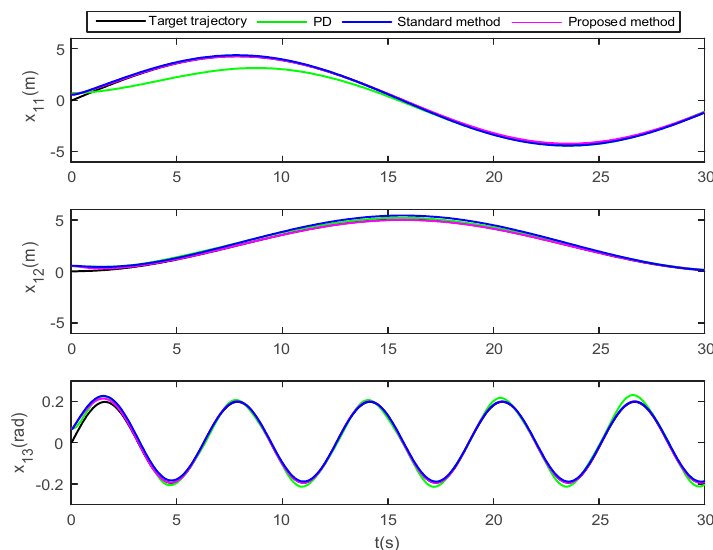
Figure 3. Position of the vessel in the XY plane under three control methods.